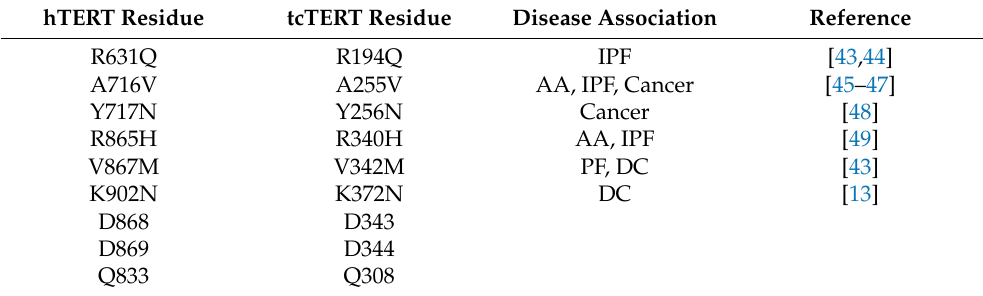
Table 1. hTERT disease-associated variants and homologous tcTERT variants investigated in this study